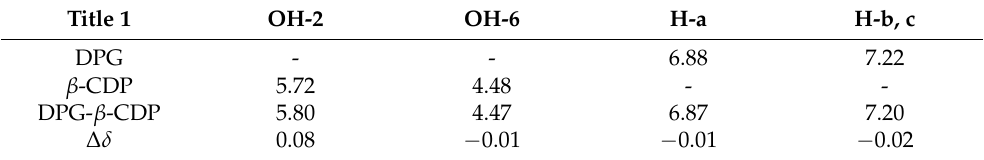
Table 1. Chemical shift δ and ∆ δ of protons of DPG, β -CDP, and DPG- β -CDP.